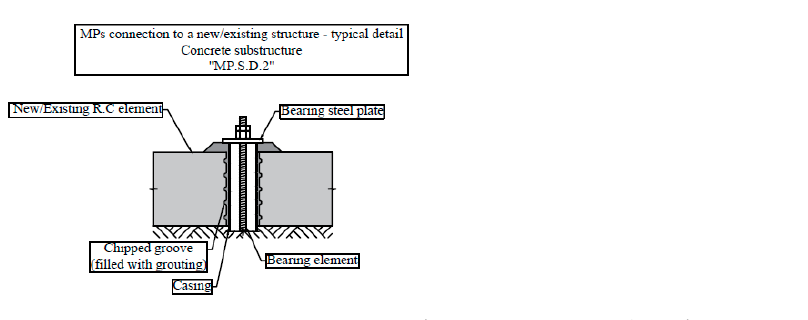
Figure 12. MP connection to a new/existing structure (new/existing reinforced concrete footing)—typical detail (after [1]).